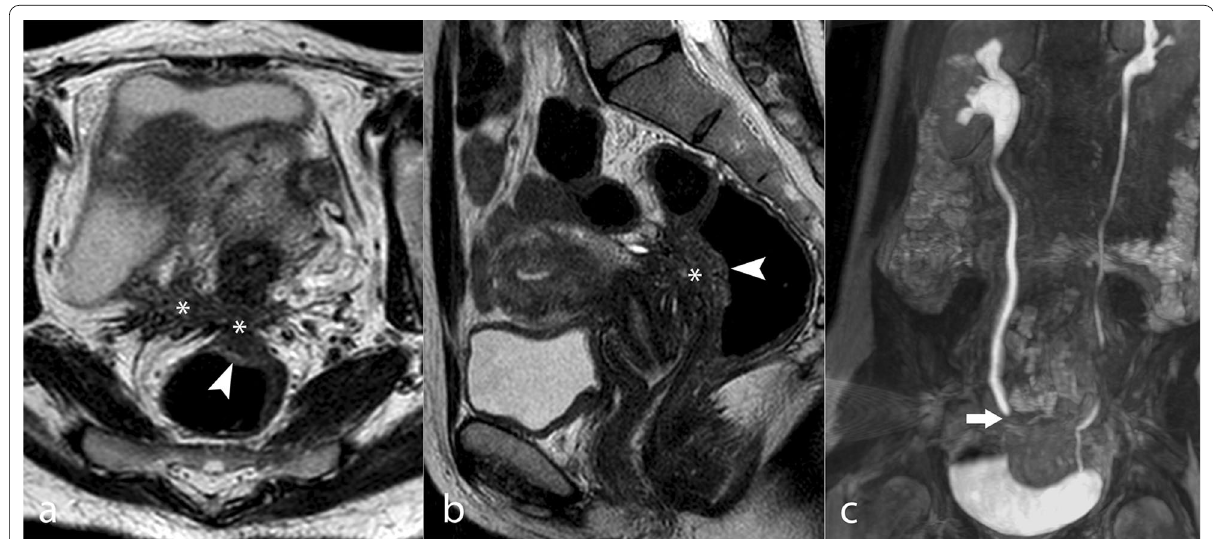
Fig. 7 Severe DIE with ureteral involvement. TSE T2w axial image ( a ), TSE T2w sagittal image ( b ) and CE MR urography ( c ). Large DIE nodule of the pouch of Douglas extending to the right USL (*) and the anterior rectal wall (arrowhead). MR urography shows the involvement of the right